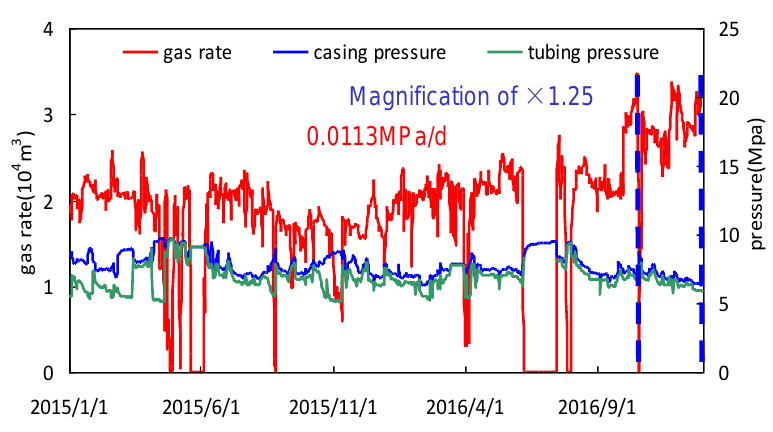
Figure 9—Well X-2 production history (II).